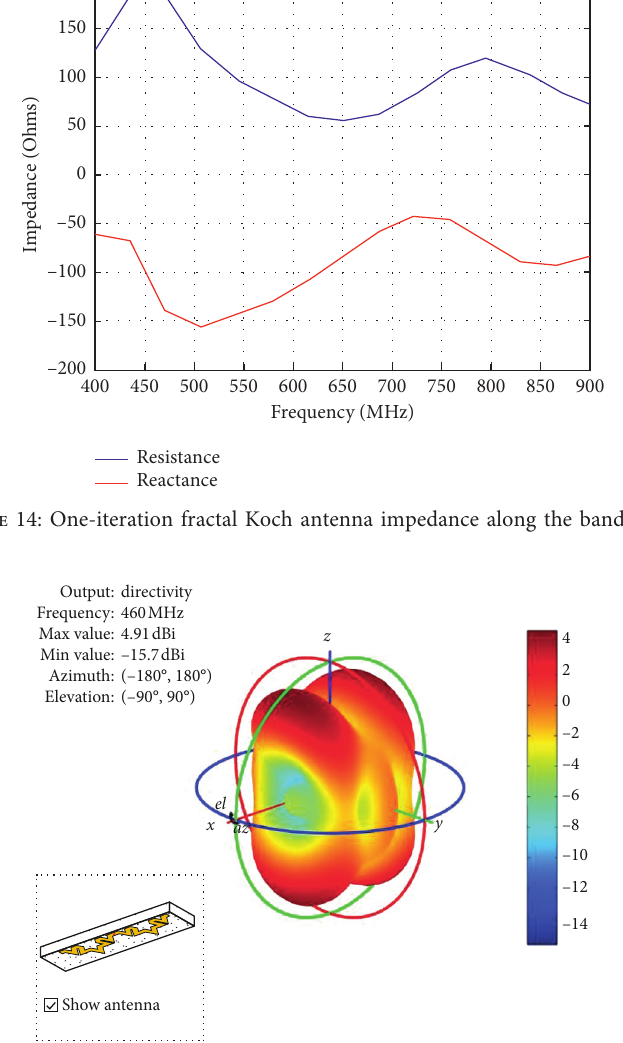
Figure 15: Two-iteration fractal Koch antenna radiation pattern and phase at 460MHz.